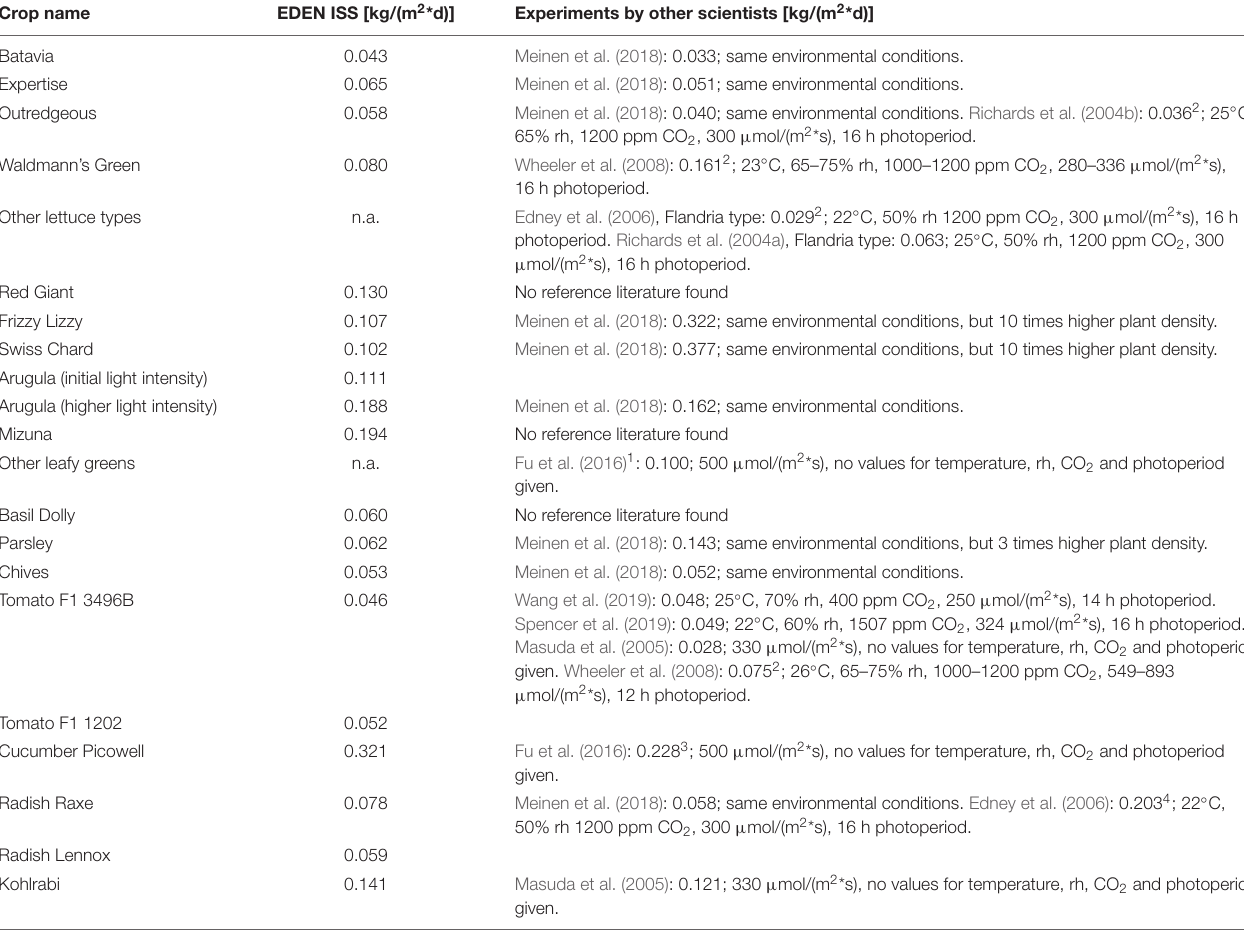
TABLE 10 | Comparison of EDEN ISS time normalized edible fresh biomass production rate to the results of experiments by other scientists. Crop